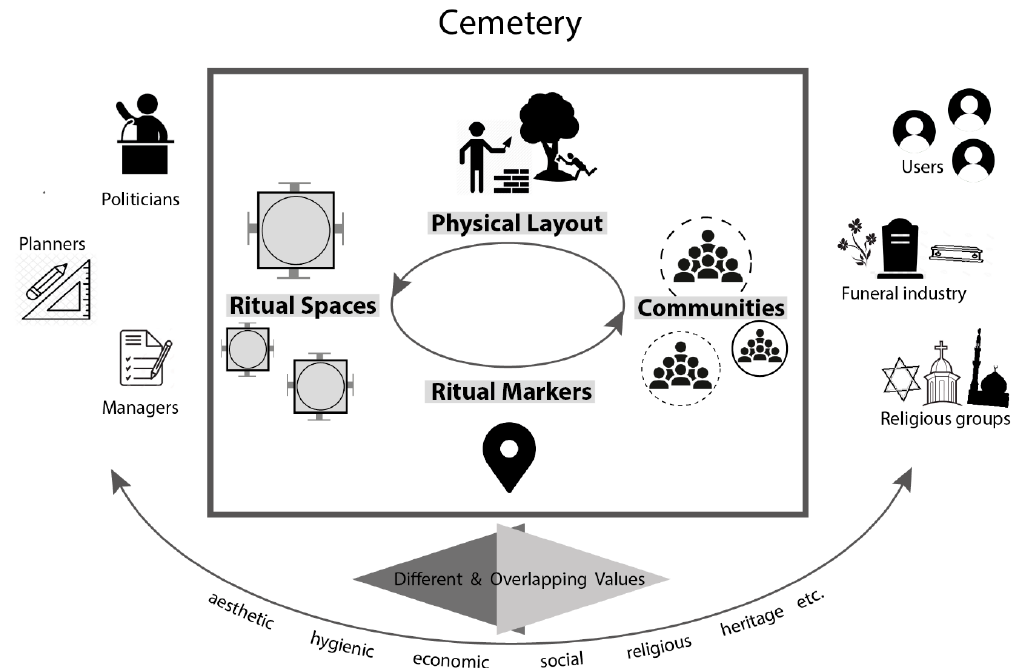
Figure 10. The Arena Model of cemeteries as dynamic ritual spaces (model: C.J., infographic: T.K.).